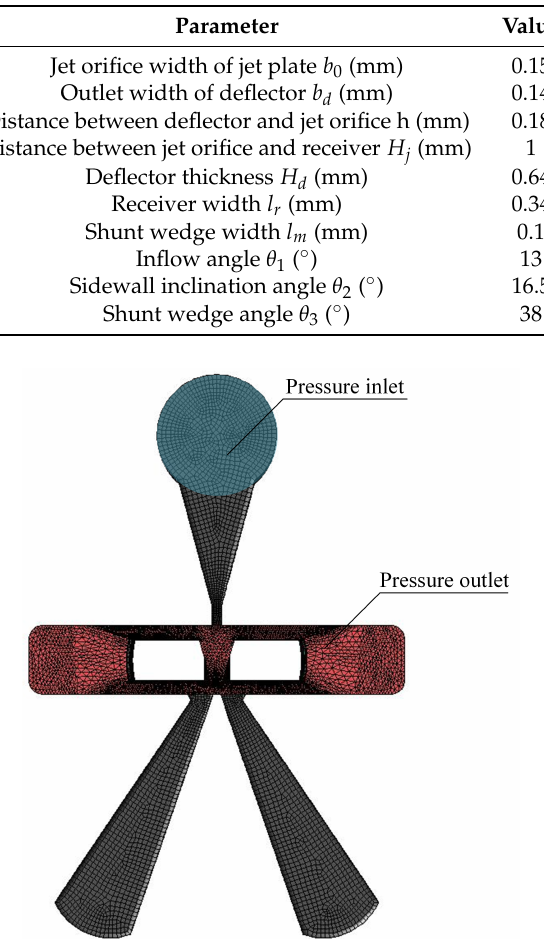
Figure 5. Numerical model of the deflector jet